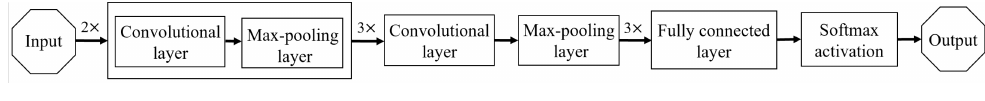
Figure 4. Simplified illustration of the AlexNet architecture.